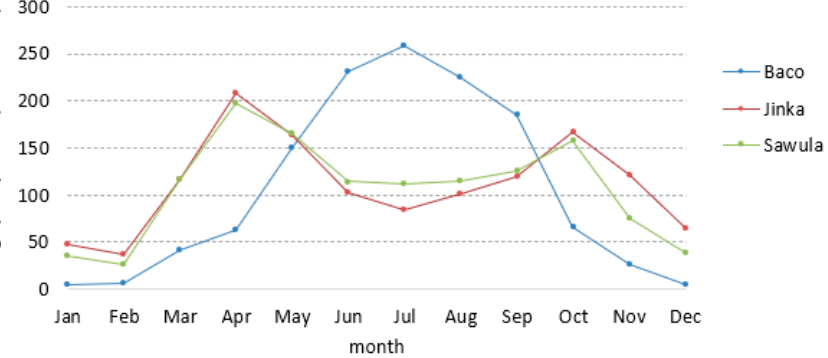
Figure 4. Average monthly precipitation for weather stations at Baco (1998–2017), Jinka (1998–2018), and Sawula (1998–2018) [21].